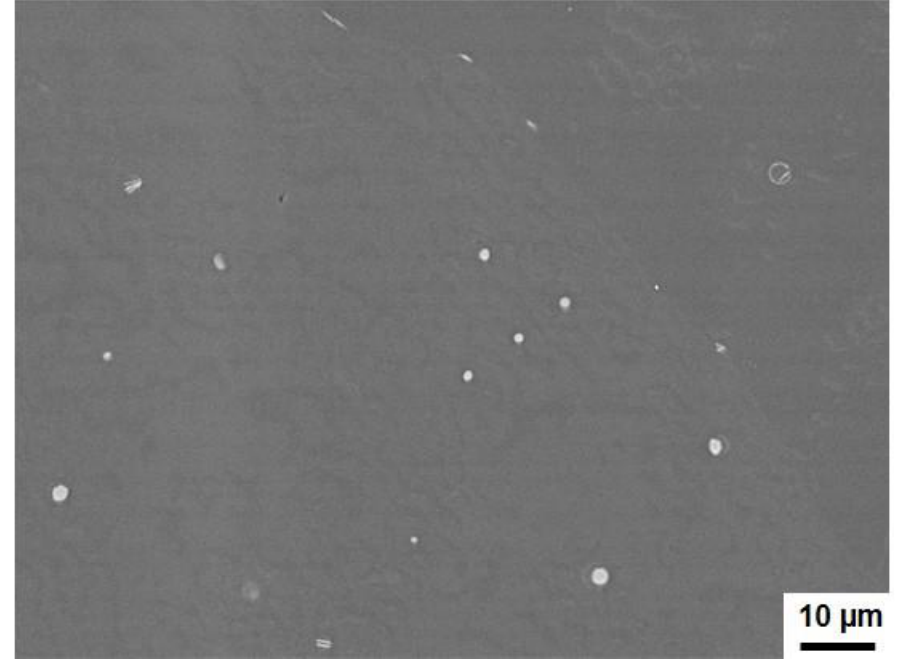
Figure 13. A typical SEM view of particles of third type.